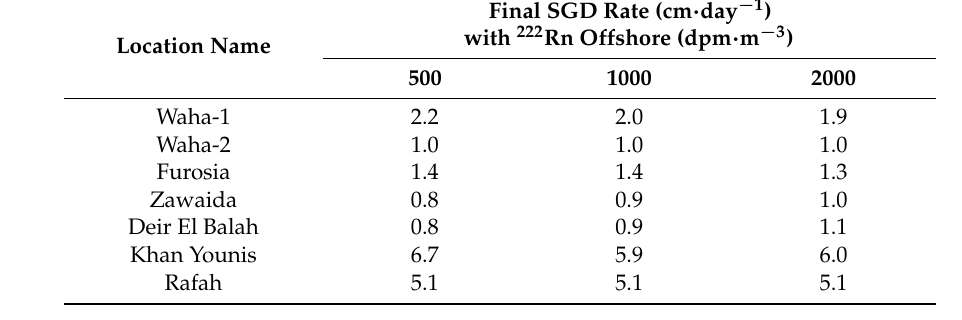
Table 4. Sensitivity analysis for the effect of 222 Rn offshore to the calculated submarine groundwater discharge (SGD) rate.